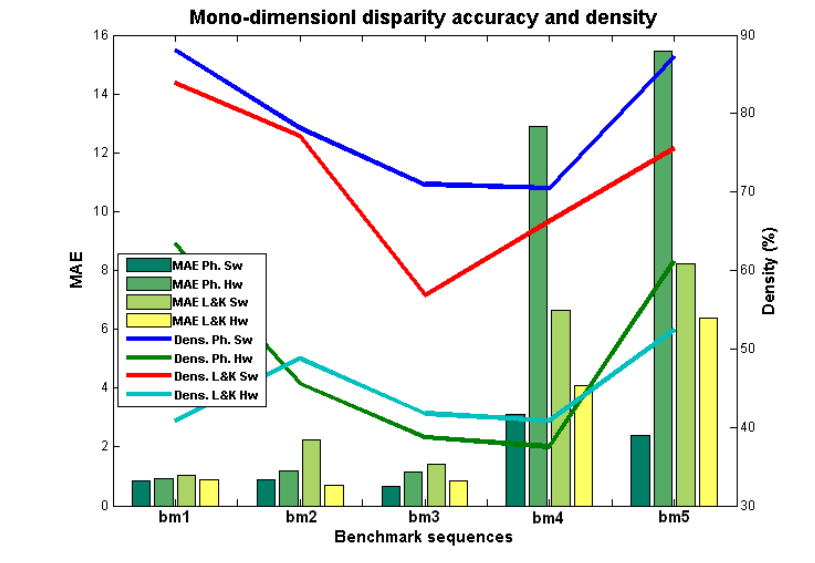
Figure 7. Horizontal disparity comparison: Lucas–Kanade vs. Phase-based and Hardware vs. Software versions (MAE and density).